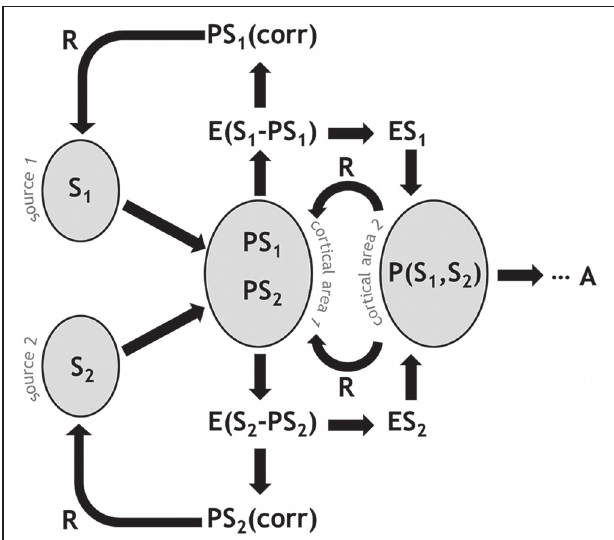
FIGURE 1 | Schematic illustration of predictive coding and error-based regulation in the PRA model of pain processing . A given cortical area receives signals (S) from multiple input sources. Predictions (PS) in the neural population represent the expected input values. An error signal (E) arises from the disparity between S and PS. A PScorr feeds back to previous stages. Higher-order predictions are likely to take multiple signal sources into account, e.g., P (S 1 , S 2 ). Ultimately, this process results in a behavioral response or action (A).